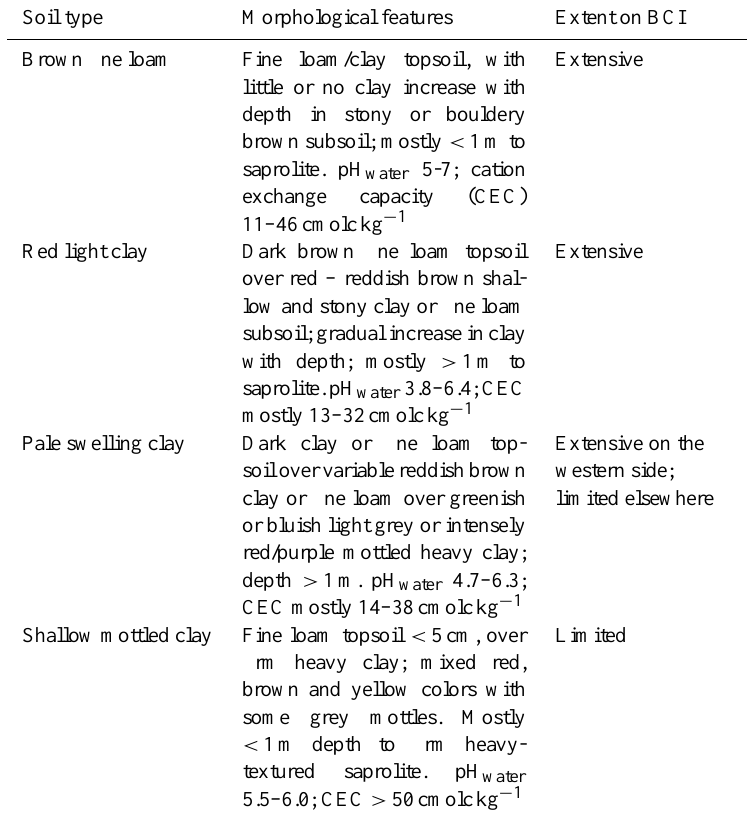
Table 1. Soil types based on texture from the soil survey report by Ballie et al. (2006). Due to the limited extent of the shallow mottled clay soil, it was excluded from subsequent